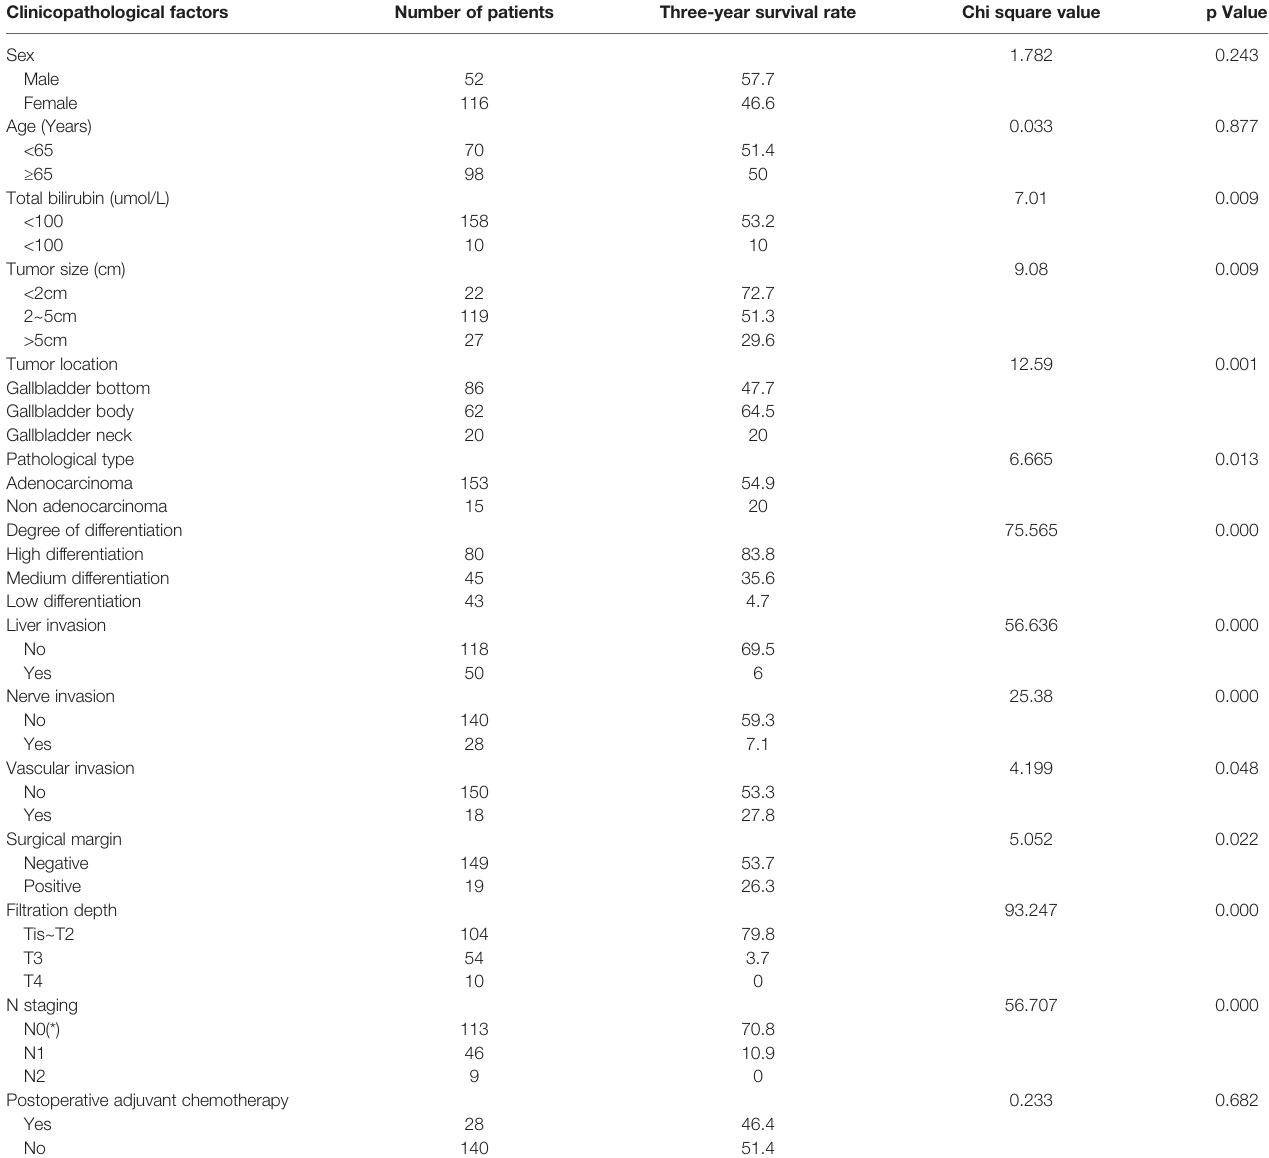
TABLE 1 | Univariate prognostic analysis of 168 patients with gallbladder